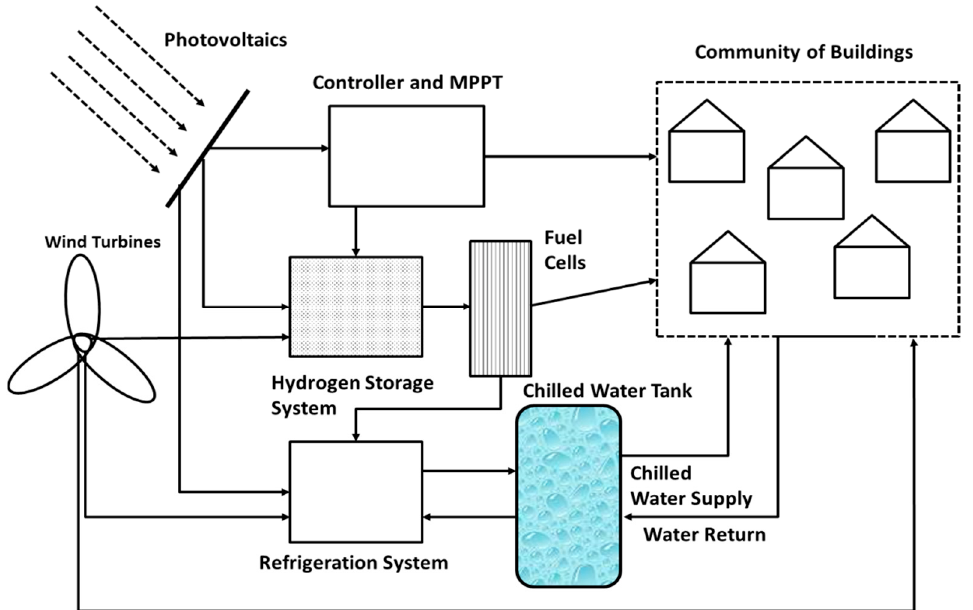
Figure 2. Schematic diagram of the grid-independent community of buildings with hydrogen stor- age and thermal energy storage. and thermal energy